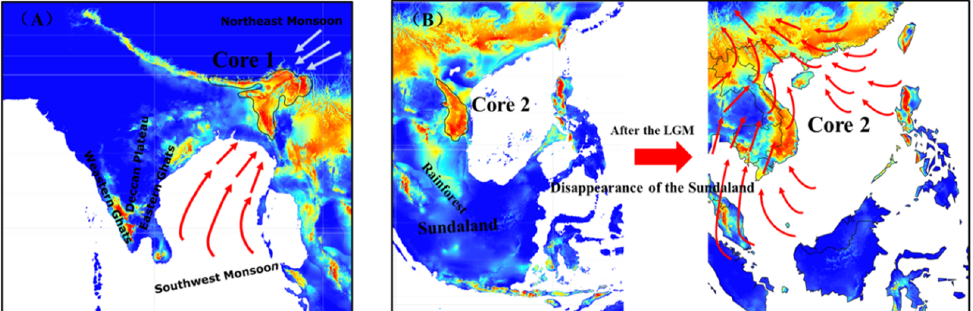
Figure 7. The causes of historical core habitats of N. chinensis in South and Southeast Asia at the last glacial maximum. ( A ), Core 1 is affected by the monsoons; ( B ), Core 2 is affected by monsoons and the disappearance of Sundaland.